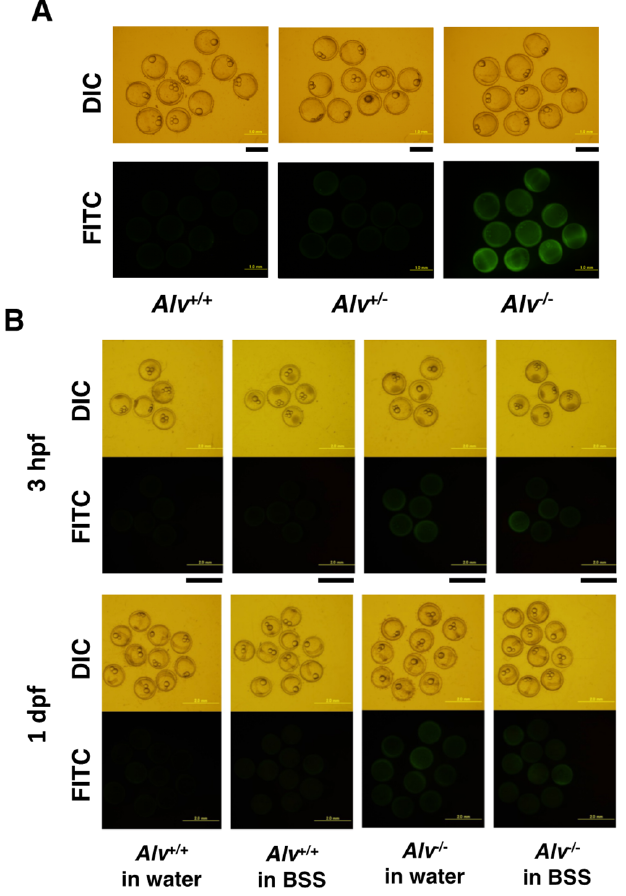
Figure 5. Permeability of the chorions. Images of the fertilized eggs after the incubation with FITC- dextran are shown. The upper and lower panels are differential interference contrast and fluorescent images, respectively. ( A ) Images of the fertilized eggs at 3 hpf with Alv +/+ and Alv − / − genotypes. Alv +/+ , Alv +/+ fertilized eggs in water; Alv − / − , Alv − / − fertilized eggs in water. The scale bars, 1 mm; ( B ) Images of the fertilized eggs at 3 hpf and 1 dpf of Alv +/+ eggs in water, Alv +/+ eggs in BSS, Alv − / − eggs in water, and Alv − / − eggs in BSS. The scale bars, 2